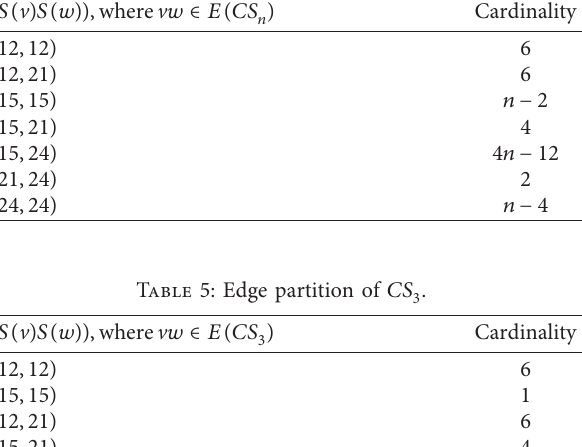
Table 4: Edge partition of CS